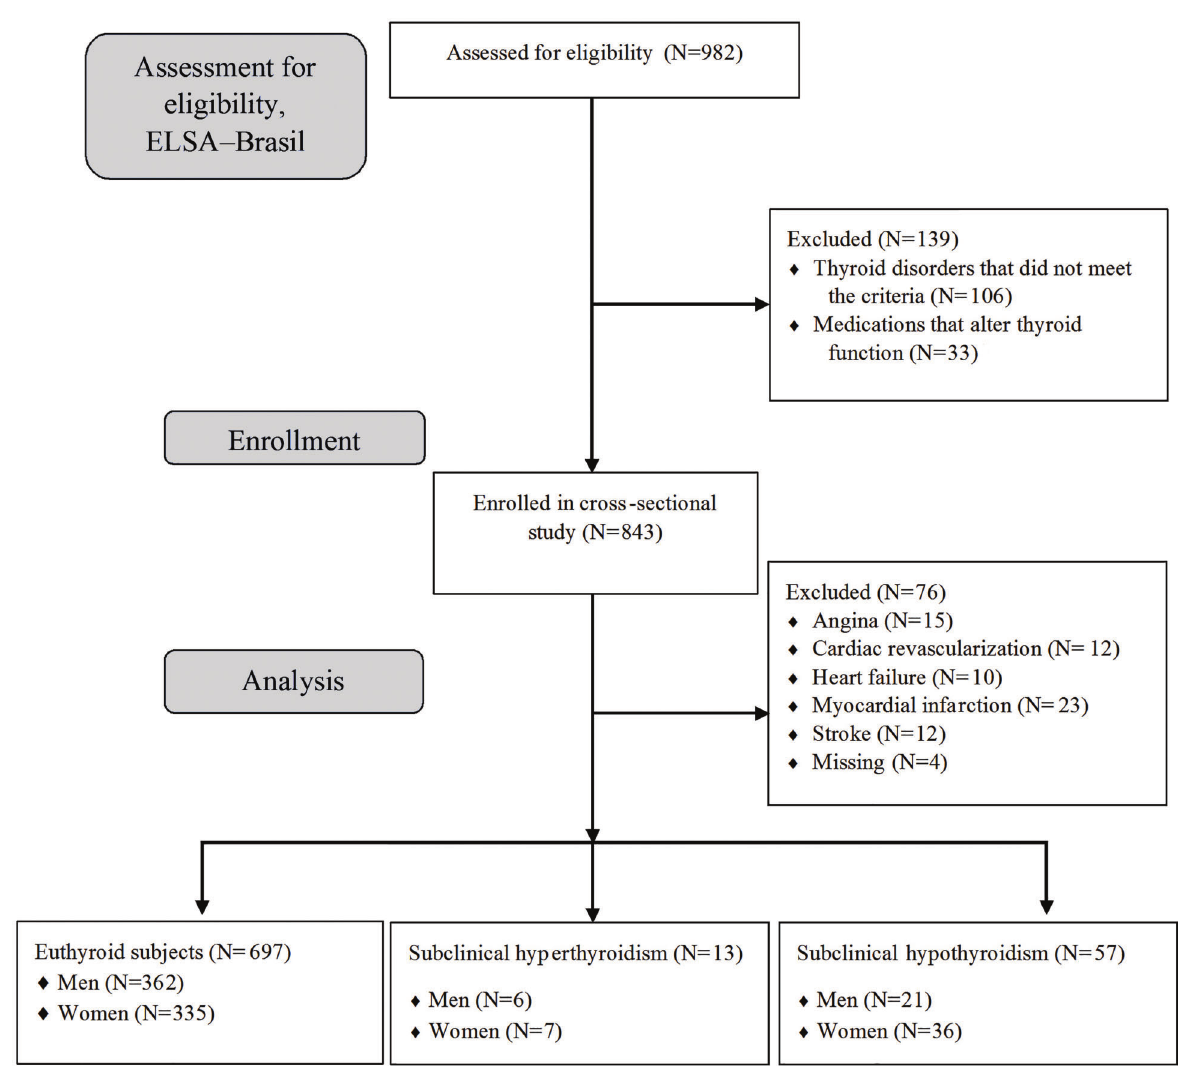
Figure 1. Study fl ow-chart. CCTA: coronary computed tomography angiography. Medications (n=33): propranolol (n=23), primidone (n=2), carbamazepine (n=2), lithium (n=2), amiodarone (n=1), furosemide (n=1), levodopa (n=1), and valproic acid (n=1); phenytoin, carbidopa, metoclopramide, heparin, haloperidol, interferon